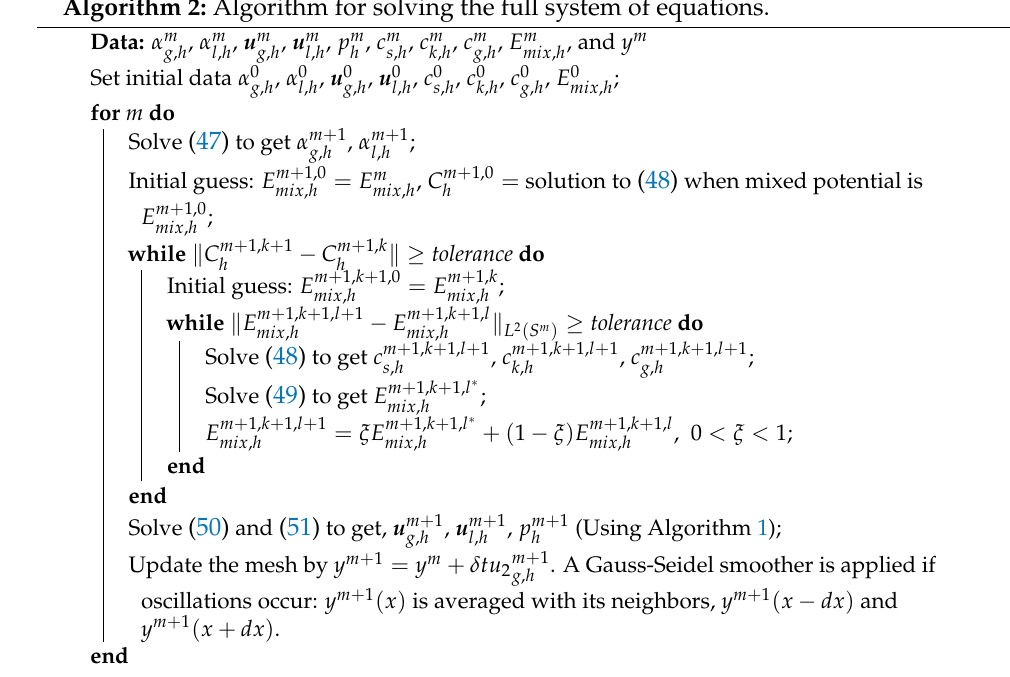
Algorithm 2: Algorithm for solving the full system of